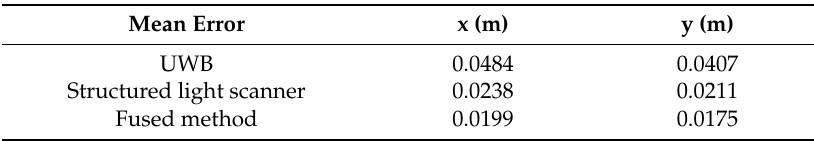
Table 4. Mean errors for different methods.